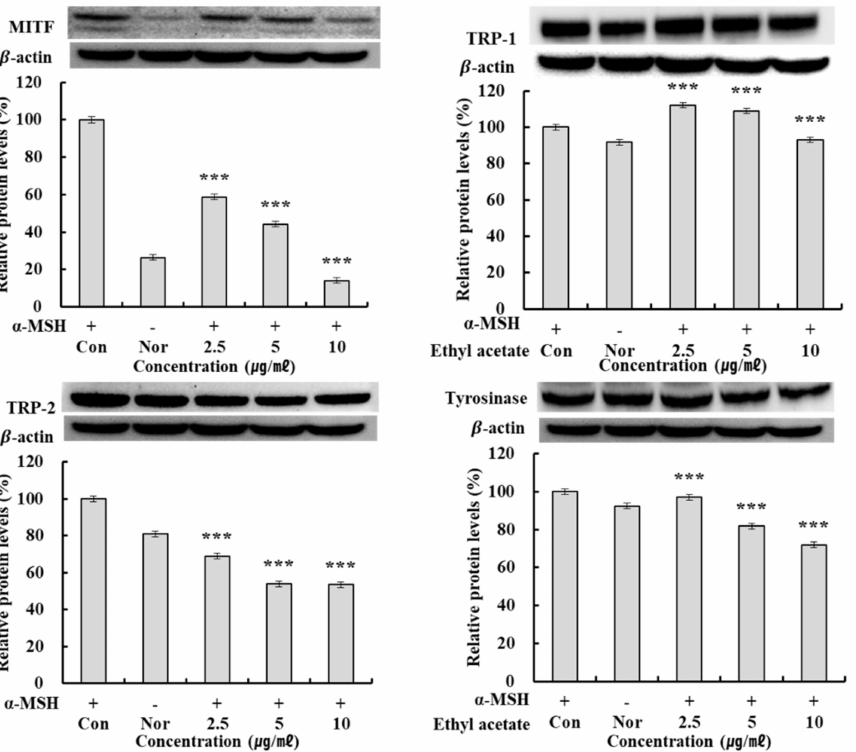
Figure 5. MITF, TRP-1, TRP-2, tyrosinase protein expression rate of ethyl acetate fraction on melanoma cells. B16F10 cells were incubated for 24 h in DMEM containing 10% FBS and then treated with various concentrations (2.5, 5, and 10 µ g/mL) of solvent fraction for 24 h. MITF, Tyrosinase, TRP-1, TRP-2 protein level was determined by western blot. Con: control, in B16F10 cells treated with α -MSH, Nor: Normal, in B16F10 cells not treated with α -MSH. Results are means ± SD of triplicate data. *** p < 0.001; significant difference compared to